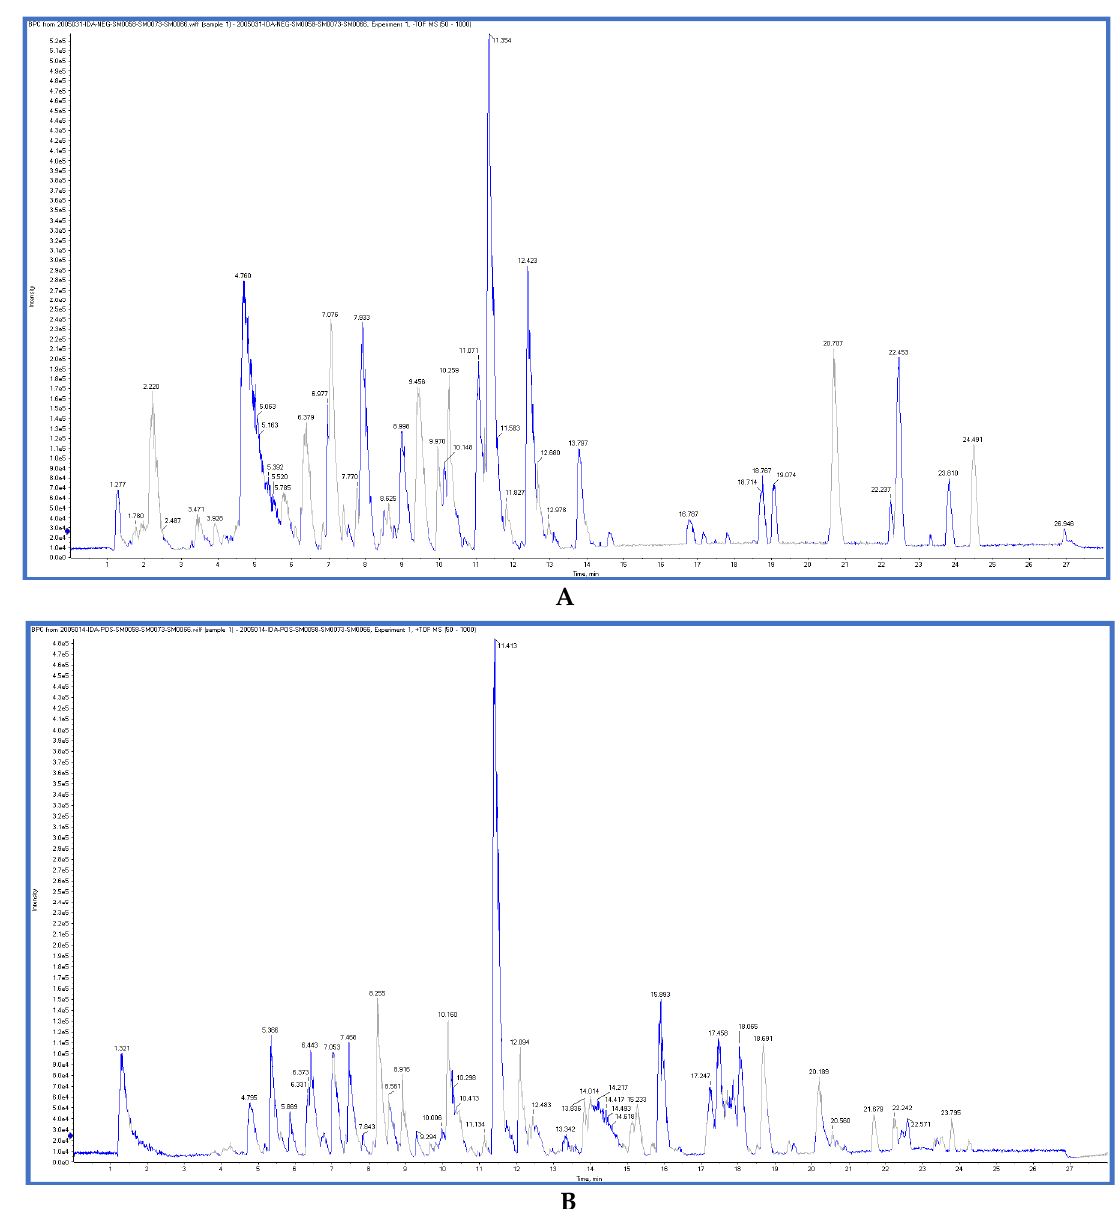
Figure 6. Chromatogram of methanolic extract of T. sanguinea in negative ion mode ( A ) and positive ion mode ( B ). Table 2. Chemical constituents of T. sanguinea extract newly identified by LC-ESI-TOF-MS/MS analysis (negative ion mode).